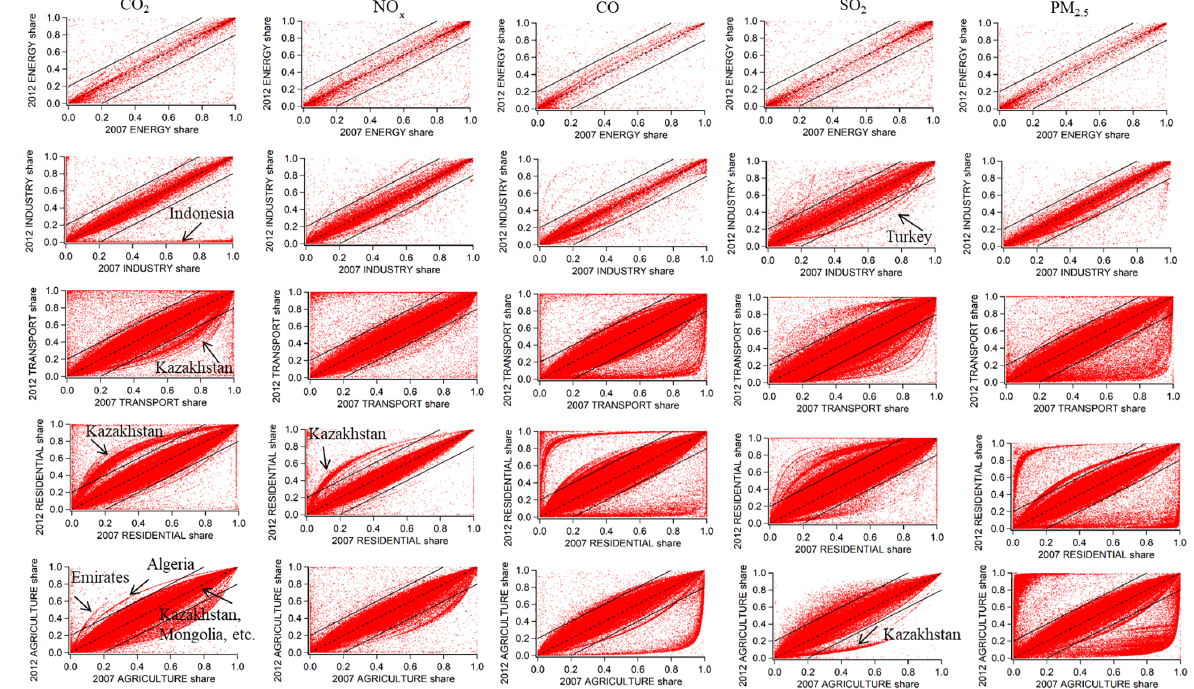
Figure 12. Comparison between the 2012 and 2007 emission shares by sector at the grid-cell level for CO 2 (reference gas), NO x , CO, SO 2 , and PM 2 . 5 . Table 1. Fraction of grid cells (represented by each point) outside the 20% deviation band is reported together with the total number of emitting grid cells (in